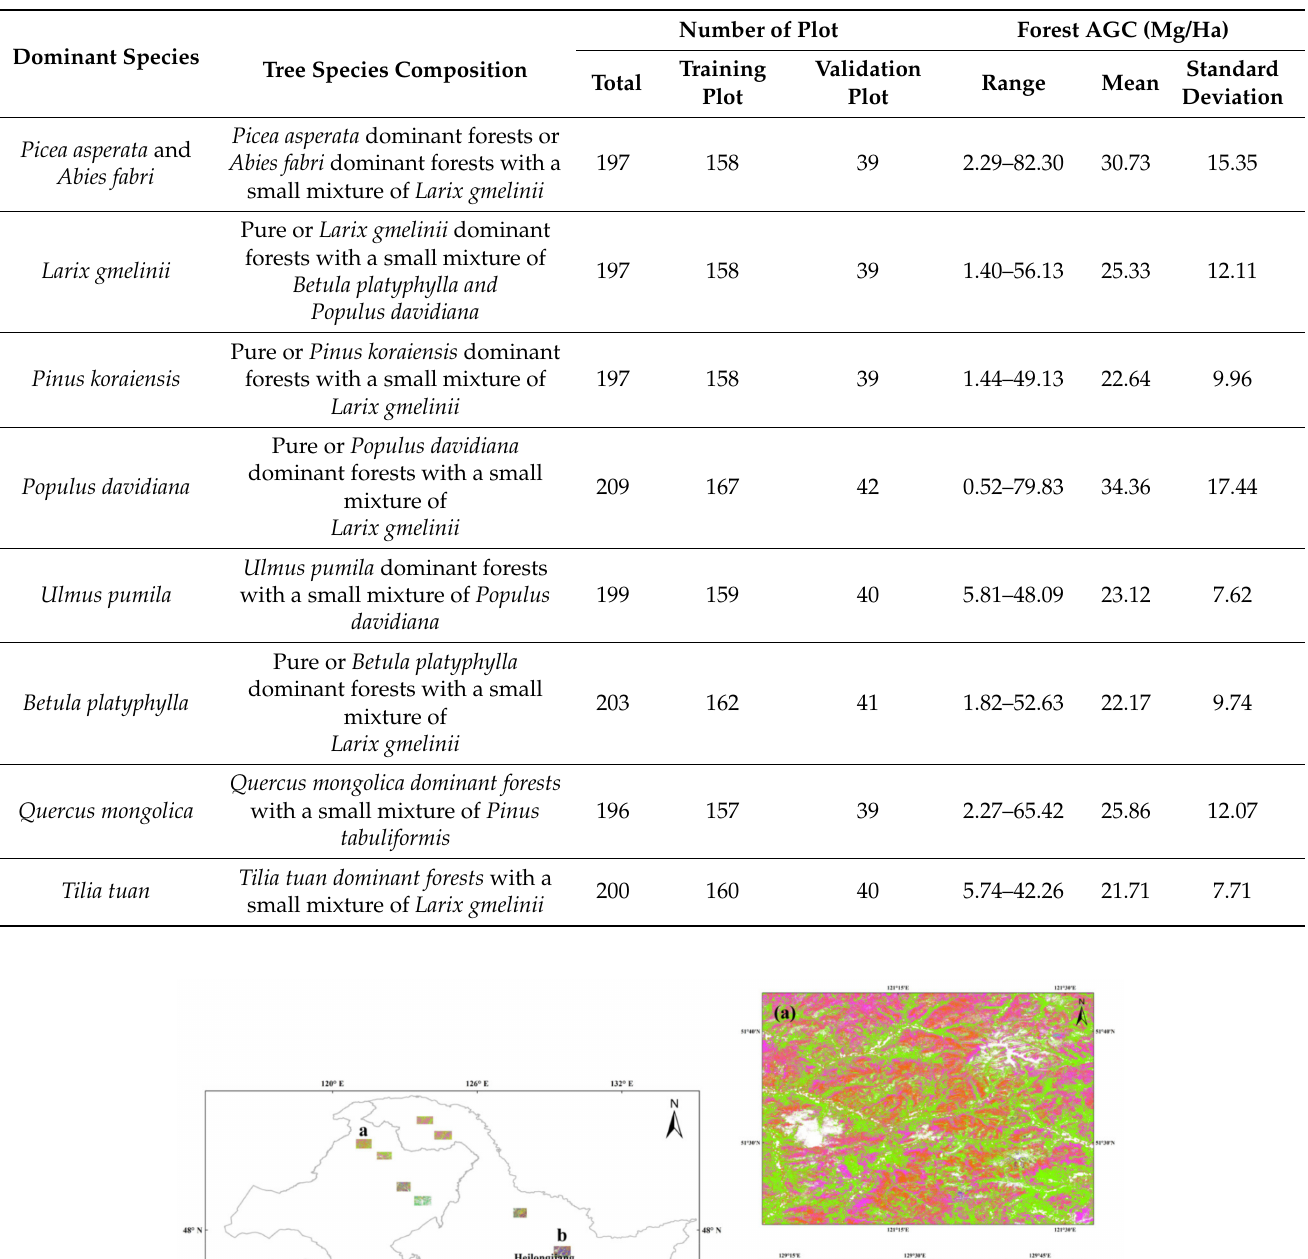
Table 3. Overview and distribution of forest AGC of the dominant-species-based stratification sample plots.